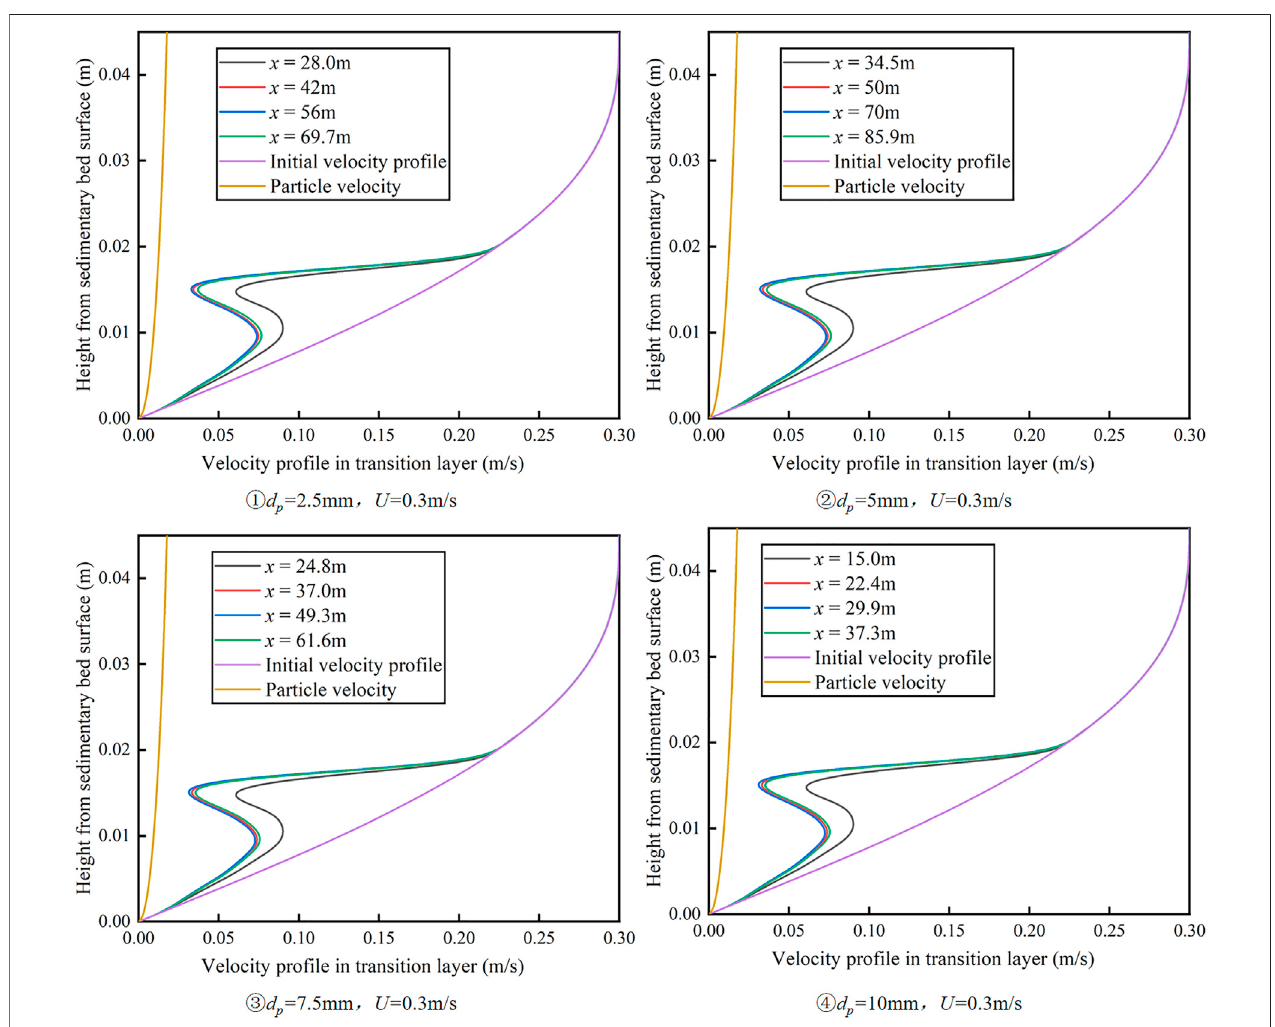
FIGURE 13 | Variation of velocity distribution in the transition layer with particle size distribution.